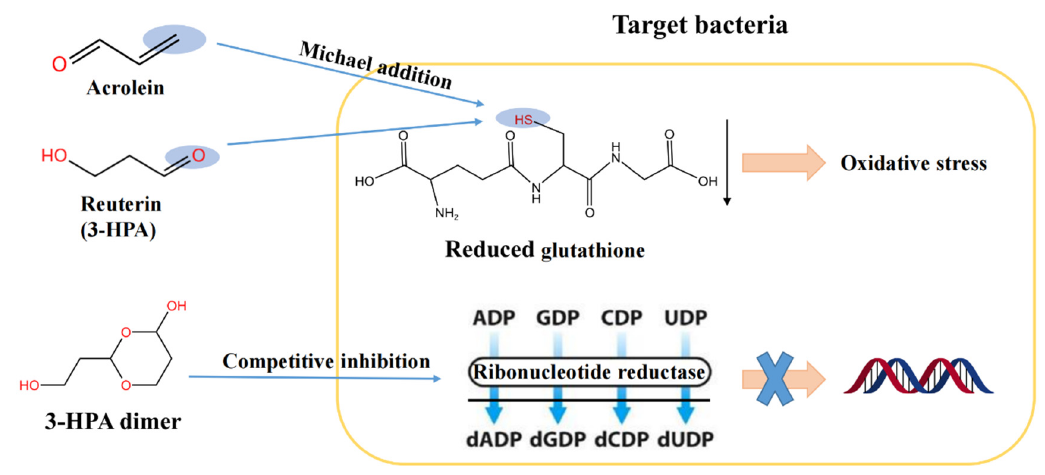
Figure 3. Three proposed antimicrobial mechanisms of the reuterin system [9,33,40,42].